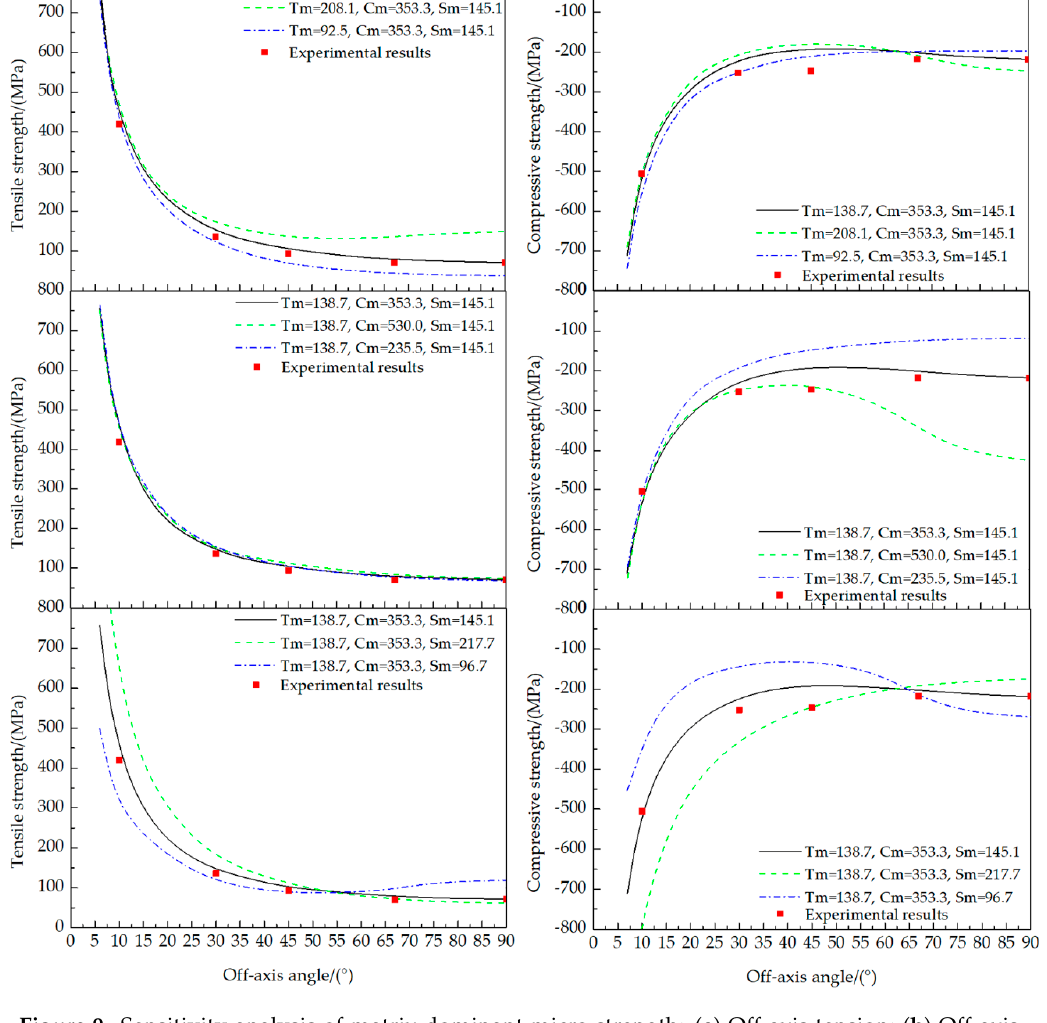
Figure 9. Sensitivity analysis of matrix-dominant micro strength: ( a ) Off-axis tension; ( b ) Off-axis compression.